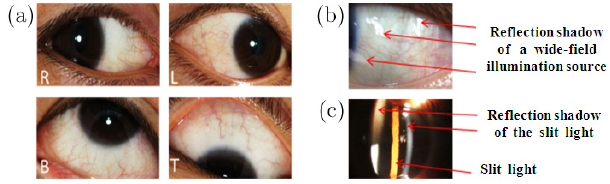
Fig. 5. Eye-feature images of (a) normal people, (b) spleen de¯ciency patients, (c) kidney de¯ciency patients, (d) patients with gallbladder diseases, and (e) liver de¯ciency